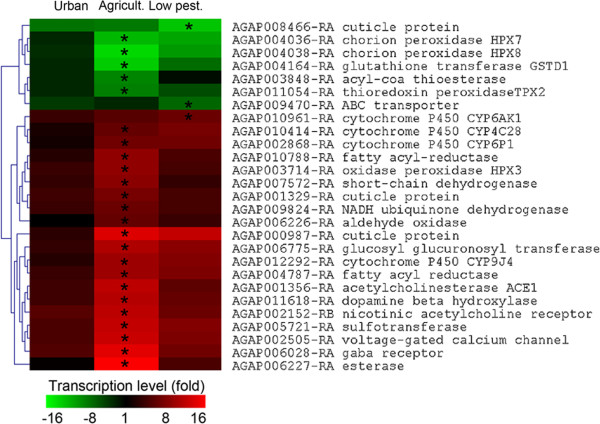
Candidate genes differentially transcribed in any area. Clustering analysis was performed on the 27 transcripts showing a significant differential expression in any area and potentially involved in insecticide resistance. Clustering of transcripts was based on differences between mean Log2 ratios in each area versus reference using Euclidean distance and complete linkage algorithm. Colour scale (green to red) indicates fold change versus reference strain. Stars indicate a significant differential transcription compared to the susceptible reference strain Ifakara (P ≤ 0.001 and FC ≥ 3).